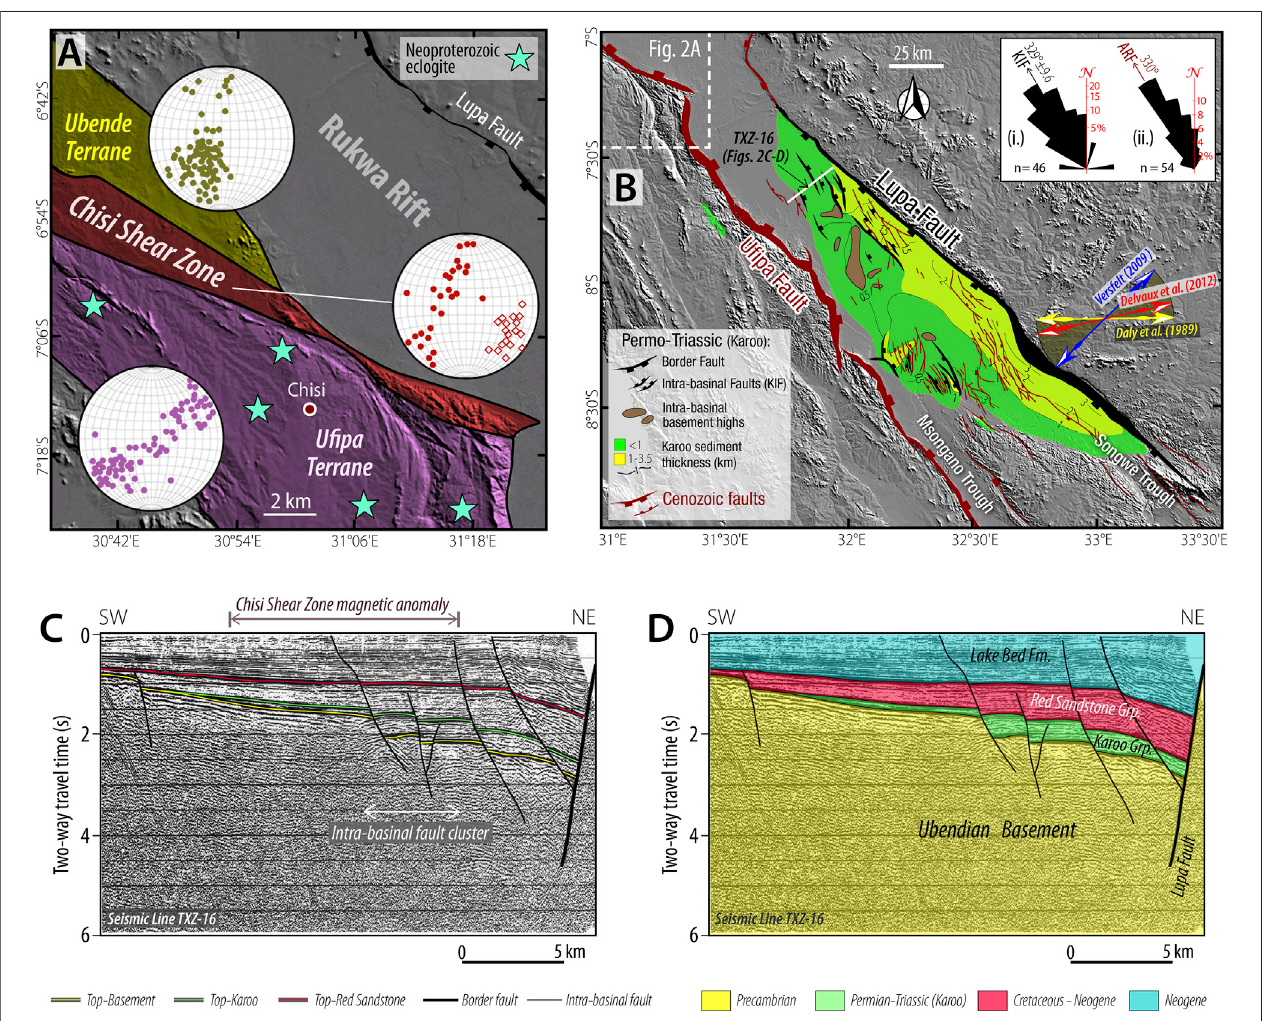
FIGURE2|(A) :Shuttleradardigitalelevationmodel(DEM)hillshademapoftheNWRukwaRiftshoulder(see Figure1B , 2B forlocation)showingthePrecambrian Chisi Shear Zone exposure and its bounding basement terranes. The plots of equal area stereographic projection (lower hemisphere) show the poles to planes of gneissic foliation ( fi lled circles), and poles of mineral elongation lineation and some fold axes of asymmetric intrafolial folds (diamonds in the Chisi Shear Zone stereonet) measuredin fi eldoutcrops(fromBovenetal.,1999).Thesestructuresrepresentthemetamorphicbasementfabricsofthebasement.LocationsofNeoproterozoic eclogitesintheChisiareaarefromBonifaceandSchenk(2012). (B) :MapoftheRukwaRiftshowingtheinterpretedKarooandpost-Karoostructuralelements(structural elements are from Morley et al., 1992, 1999). Arrows represent the previously published inferred Karoo extension directions. Inset: Frequency-azimuth distribution plot for ( i. ) Karoo-age (Permo-Triassic) intra-basinal faults (KIF) with black arrow indicating their mean trend and standard error (measured in this study), and ( ii. ) All (Permian to Quaternary) Rukwa Rift faults (ARF) with their mean trend shown as brown arrow (digitized from Morley et al., 1992). (C – D) : 2-D seismic re fl ection pro fi le line TXZ-16 and interpretation (modi fi ed from Morley et al., 1999; see location in Figure 2B ) showing the major stratigraphic boundary horizons, the Lupa border fault, and intra- basinal faults.